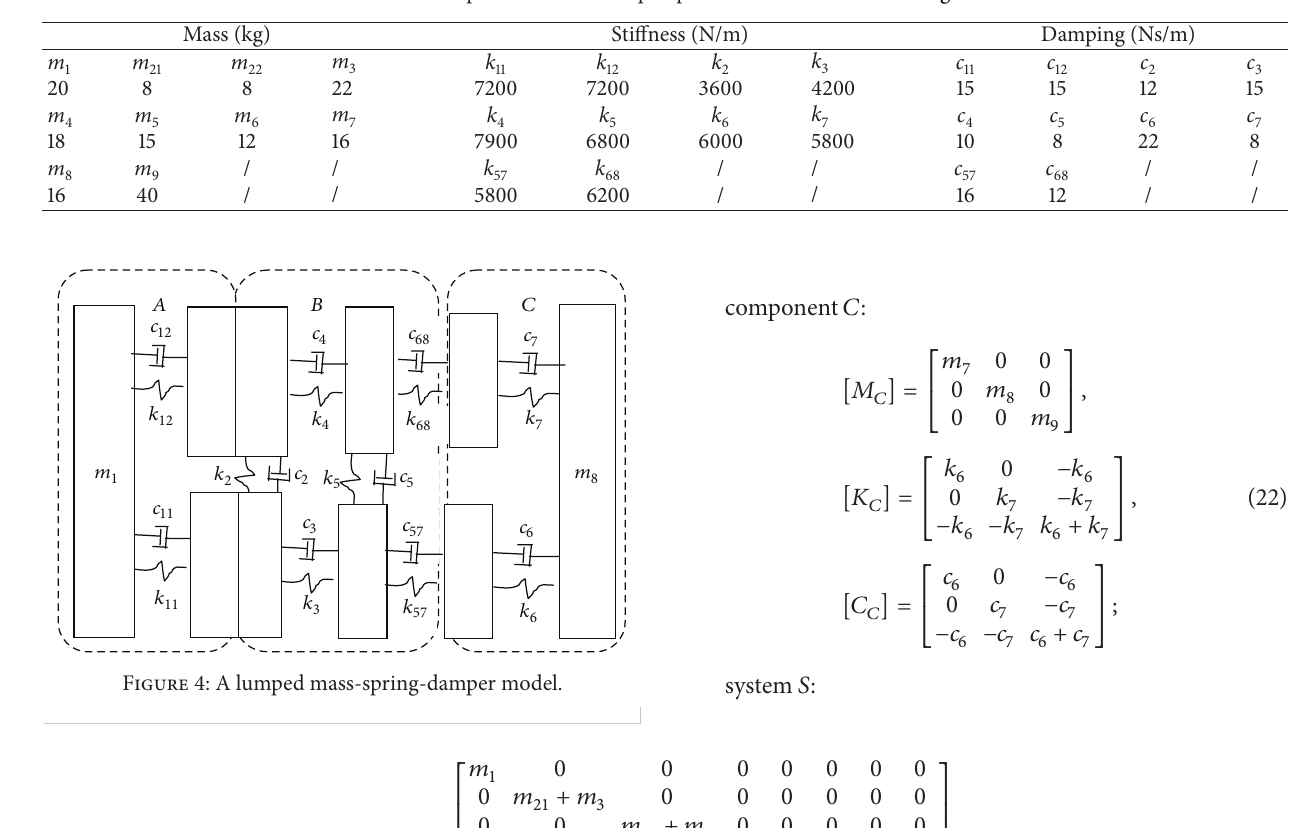
Table 1: Model parameters for lumped parameter model shown in Figure 4.